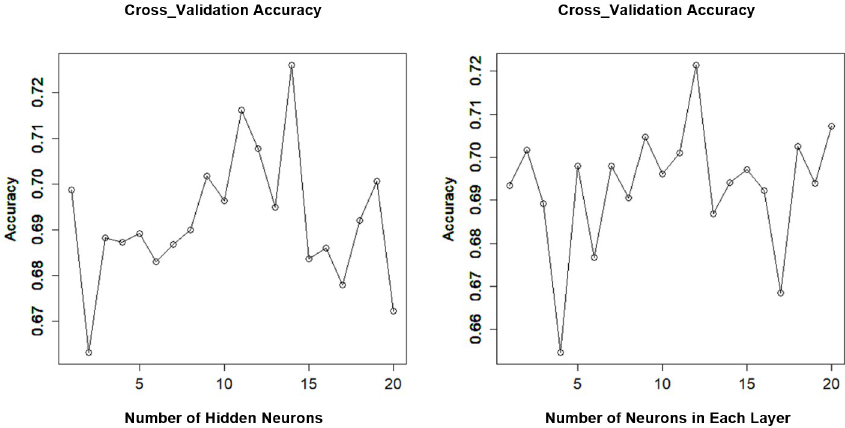
Fig 4. Tuning hyperparameter for ANN models. ANN with one hidden layer (a) and ANN with two hidden layers (b).